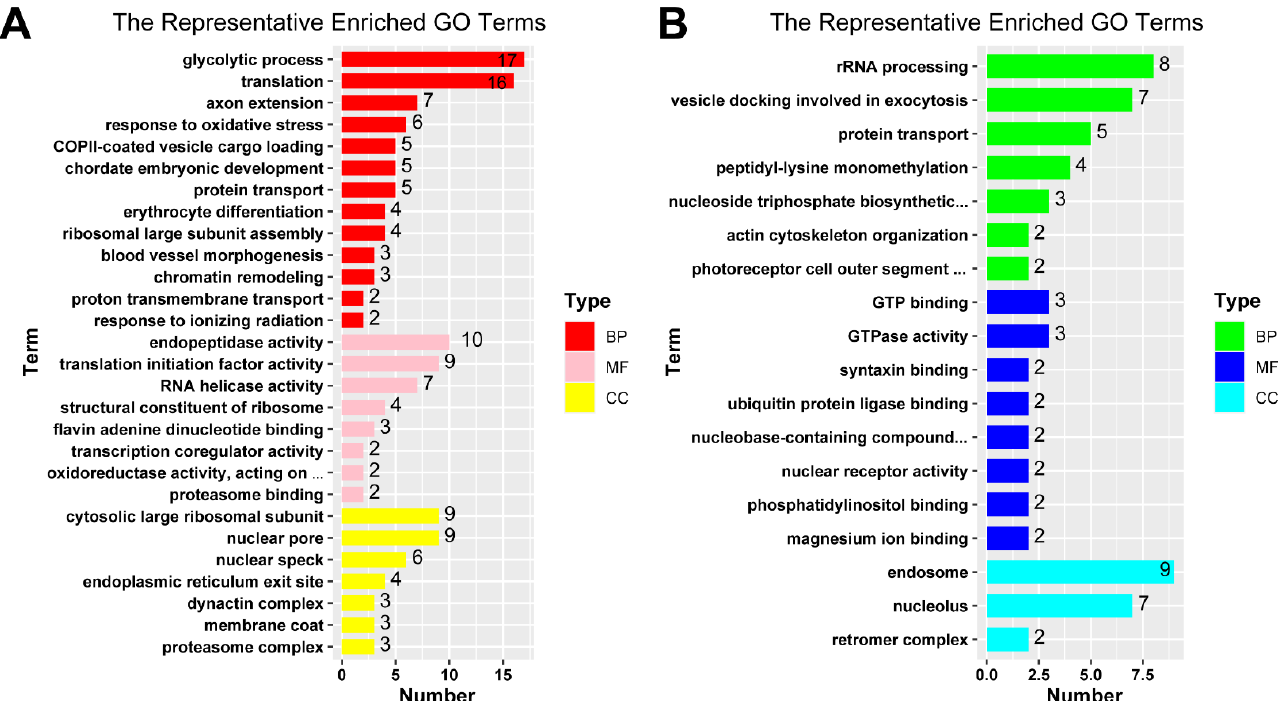
Figure 6. Bar plots for representative terms of GO enrichment analysis. GO terms redundancy were reduced by REVIGO tool to give a representative subset of terms for up-regulated key genes ( A ) and down-regulated key genes ( B ). Representative GO terms of different aspects of biology are shown in different colors, BP: biological process; MF: molecular function; CC: cellular component. Table 3. The most important biological processes inhibited at non-spawning